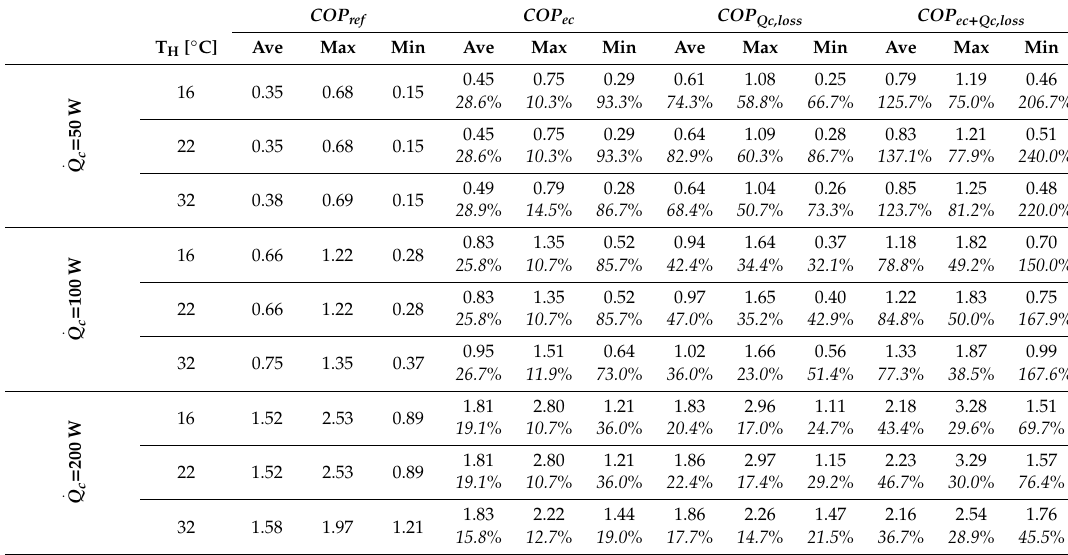
Table 4. Average ‘8MAG’ COP for di ff erent cooling power and hot source temperatures (T H ). These values were obtained by an average among the experimental data at di ff erent volumetric flow rates and operating frequencies. Temperature spans are in the range between 1 K and 8.5